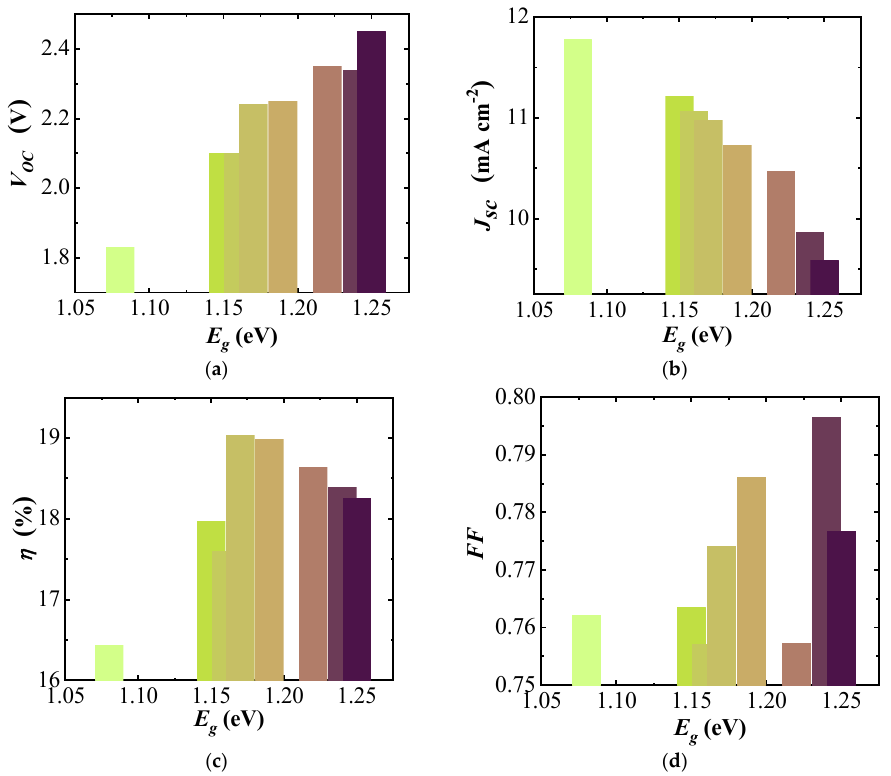
Figure 6. E g dependence of ( a ) V OC , ( b ) J SC , ( c ) η , and ( d ) FF for three-cell (A)CIGS modules.